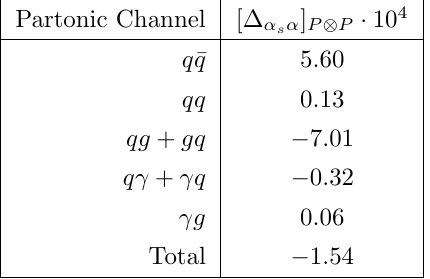
] P (cid:10) P s (cid:11)